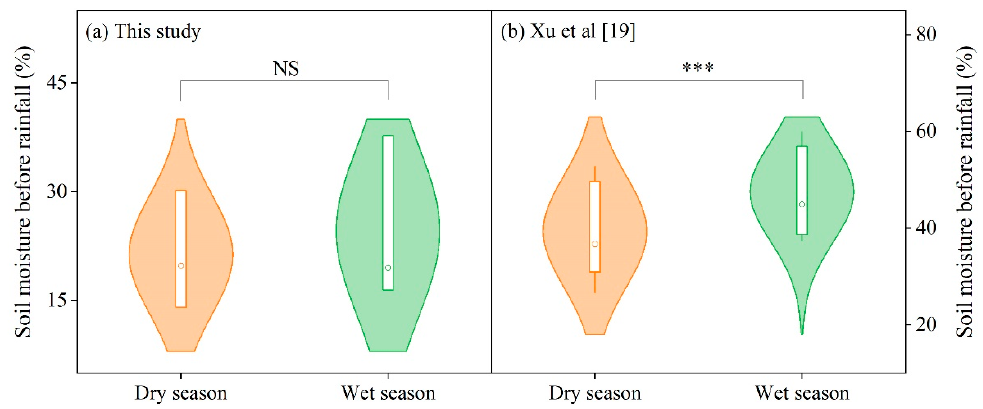
Figure 6. Comparison of soil moisture before rainfall between the dry and wet seasons in this study ( a ) and in that of Xu et al. [19] ( b ). *** p < 0.001.